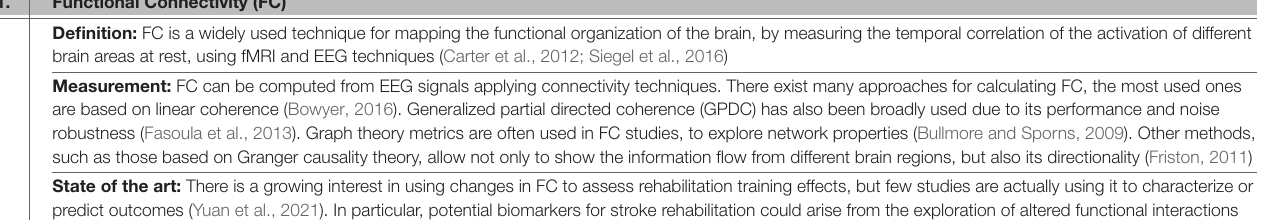
TABLE 2 | List of the electroencephalography (EEG)-based biomarkers related to the motor rehabilitation focused on stroke.